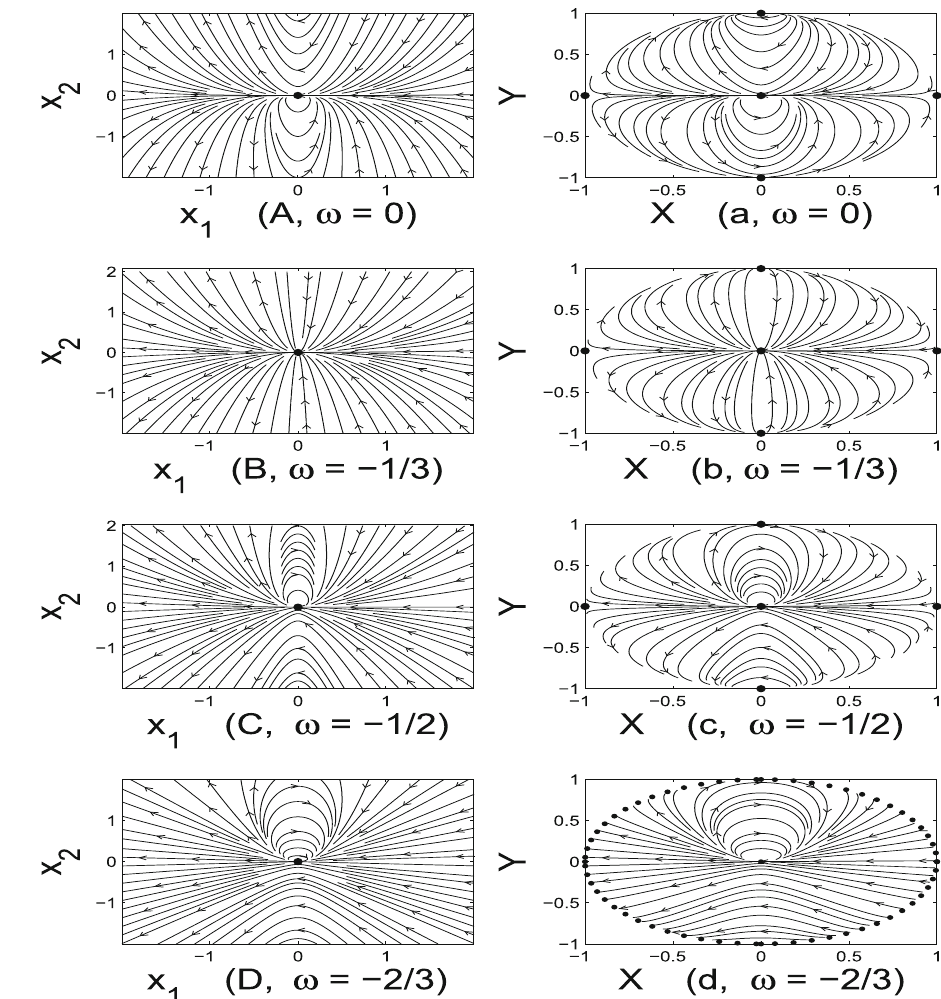
Fig. 4 Uncompact (left panel) and compact (right panel) phase portraits for the cases ω = 0 , − 1 , − 1 and − 2 . x 1 and 3 2 3 x 2 respectively denote the dimensionless ˜ H and ˜ ρ as defined in Eq. (7). X and Y are the coordinates on the Poincaré sphere as defined in Eq. (47). The dotted circles represent fixed